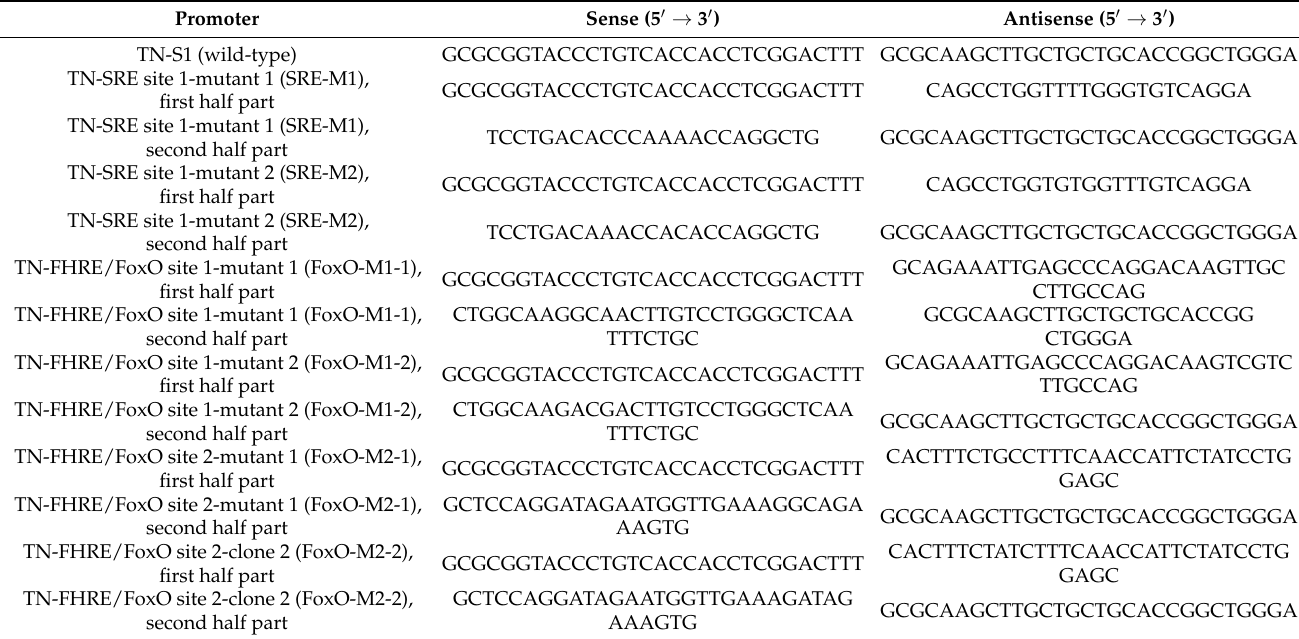
Table 2. List of primers for the putative promoter region of porcine tetranectin (TN/ CLEC3B ). Promoter Sense (5 (cid:48) → 3 (cid:48) ) Antisense (5 (cid:48) → 3 (cid:48)